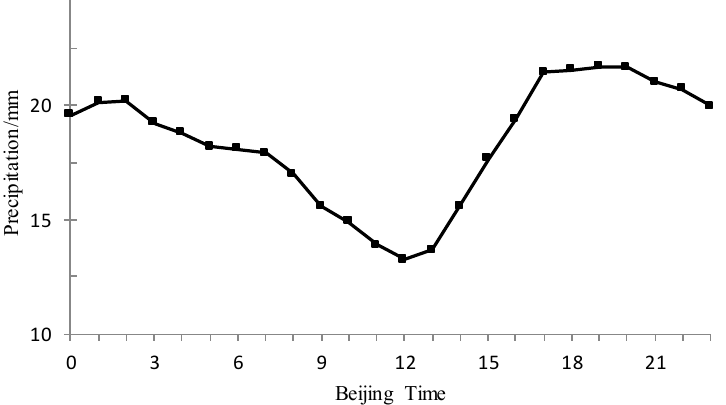
Figure 4. The diurnal variations of the basin-averaged hourly mean precipitation in the Haihe River basin.